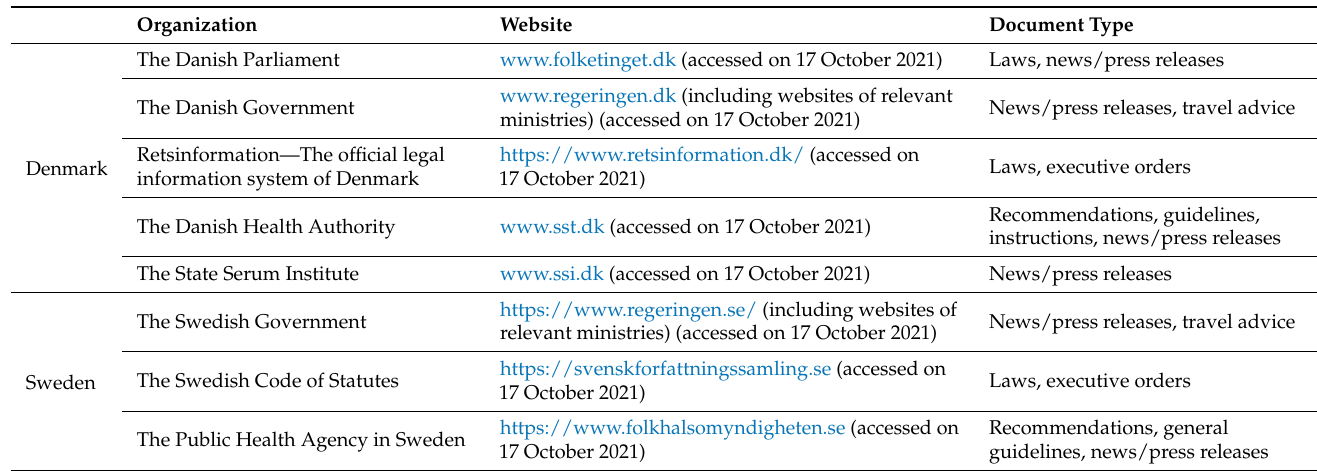
Table 1. Information about documents retrieved for the